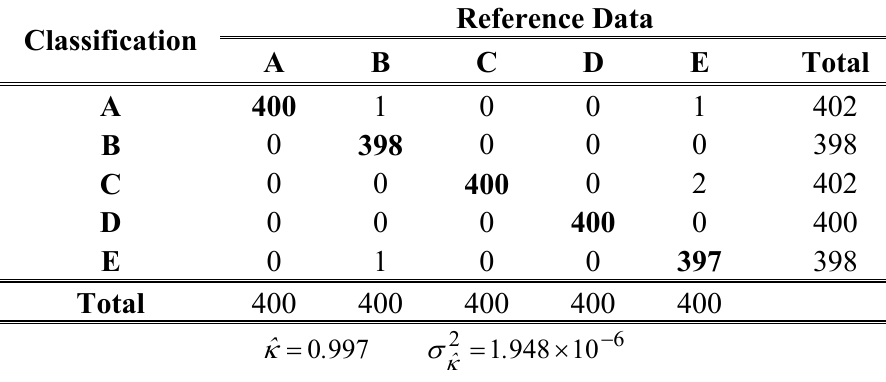
Table 10 . Confusion matrix (# of pixels) using the Gaussian bivariate distribution for PDR - PDS (C-band).